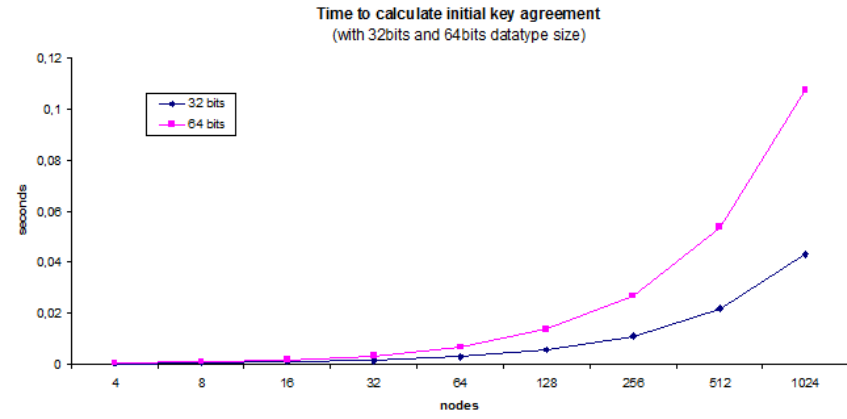
Figure 6. Time U c needs to calculate the initial key agreement message.